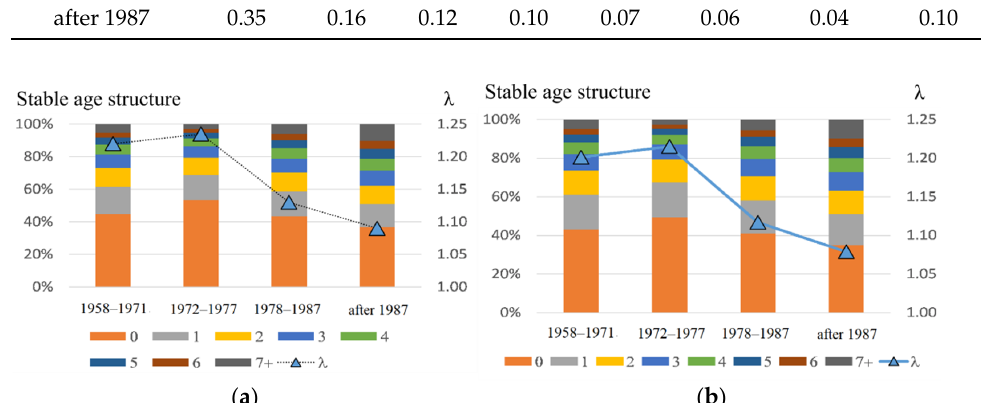
Figure 7. Stable age structure of the male part of the northern fur seal population (left axis) and annual growth rate of the population (on the right axis), corresponding to the periods: 1958–1971, 1972–1977, 1978–1987, and after 1987; here, ( a ) corresponds to the parameter estimates obtained by the iteration and ( b ) refers to the fitting method.